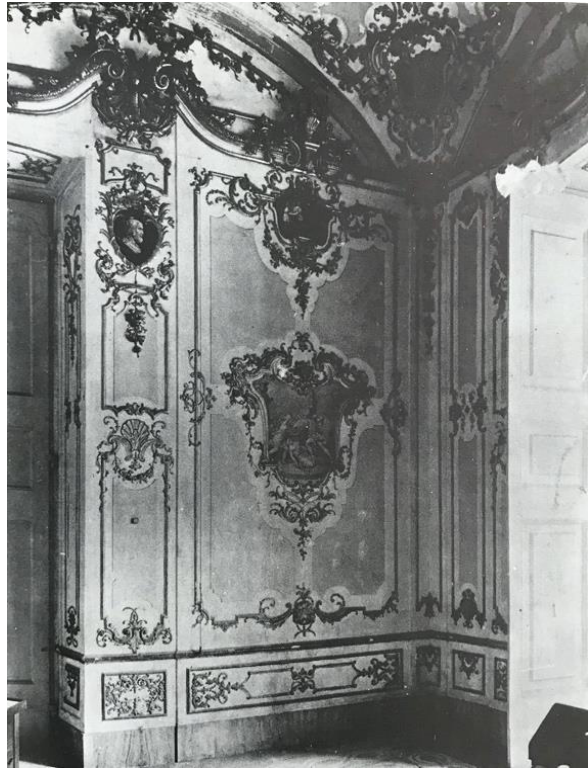
Figure 3. The Gabinetto of gilded stucco in 1980 (De Seta, Di Mauro, Perone, 1980). The lambris and decorations on the vault and wall on the right were still quite intact and paintings